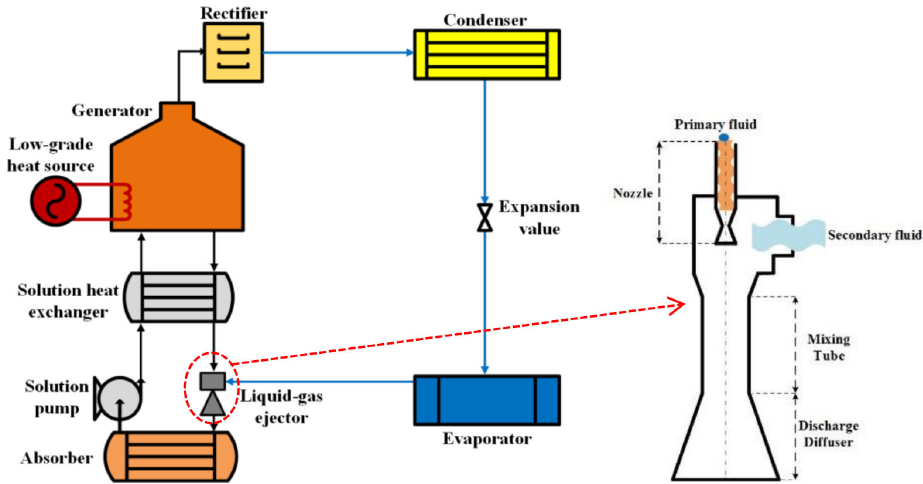
Figure 3. Schematic diagram of Hybrid Ejector-Absorption Refrigeration System (HEARS), Triple pressure level “TPL”